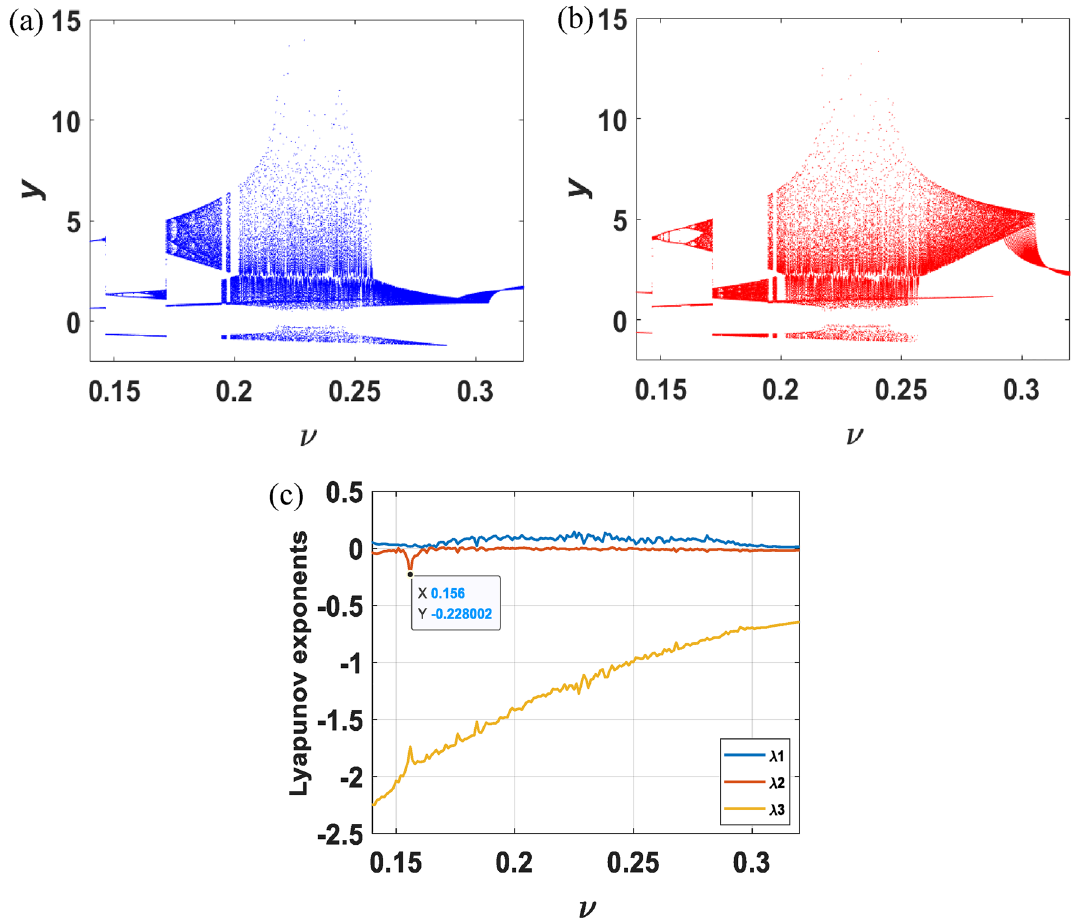
Figure 3. For the initial values (0.1, 2, 0.1) and (− 0.1, − 2, 0.1), the bifurcation diagram and Lyapunov spectrum of system (3) as v varies.